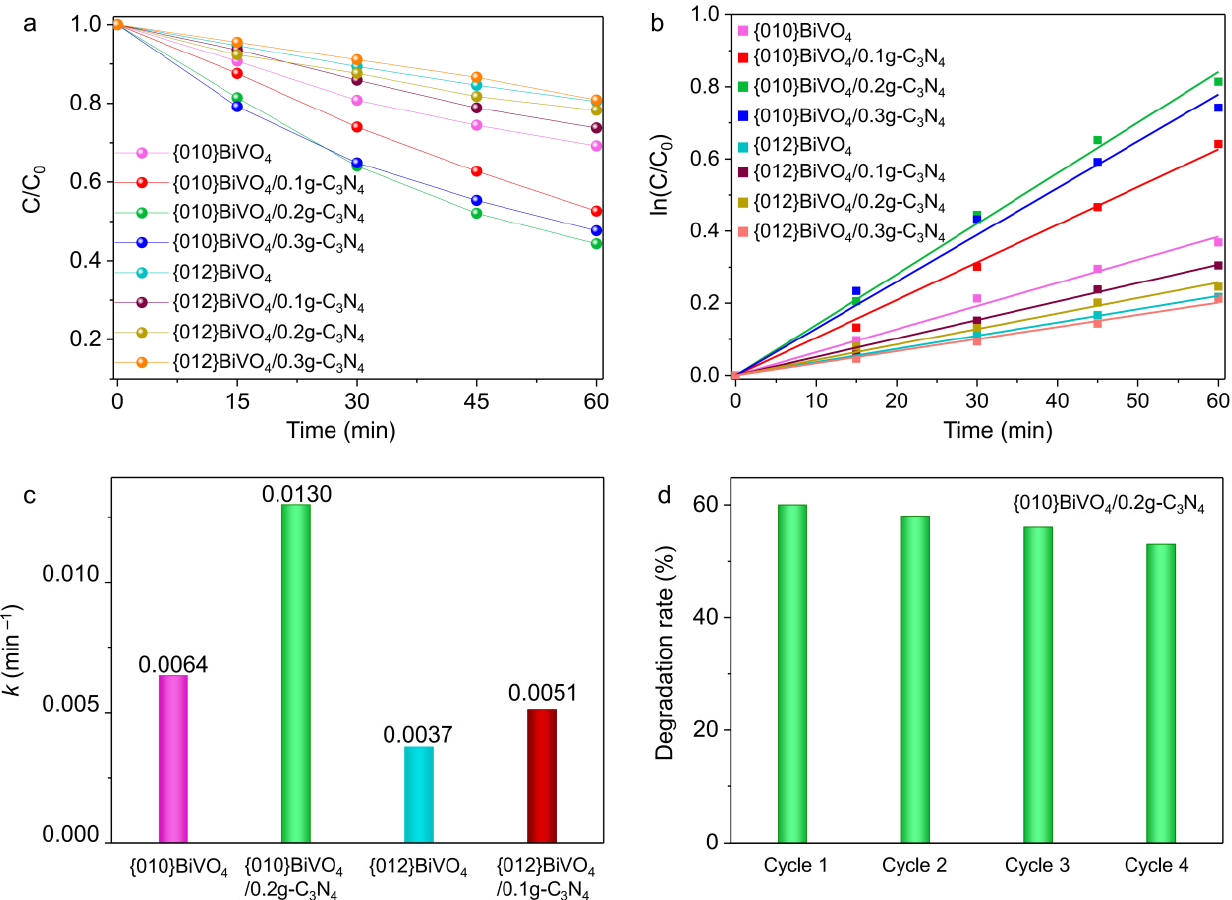
Figure 6. ( a ) The photocatalytic degradation curves of TC on {010}BiVO 4 and {012}BiVO 4 with different g-C 3 N 4 loading amounts. ( b ) The kinetic analyses of TC degradation curves with ( c ) the degradation rate constant. ( d ) Stability tests of TC degradation over {010}BiVO 4 /g-C 3 N 4 .